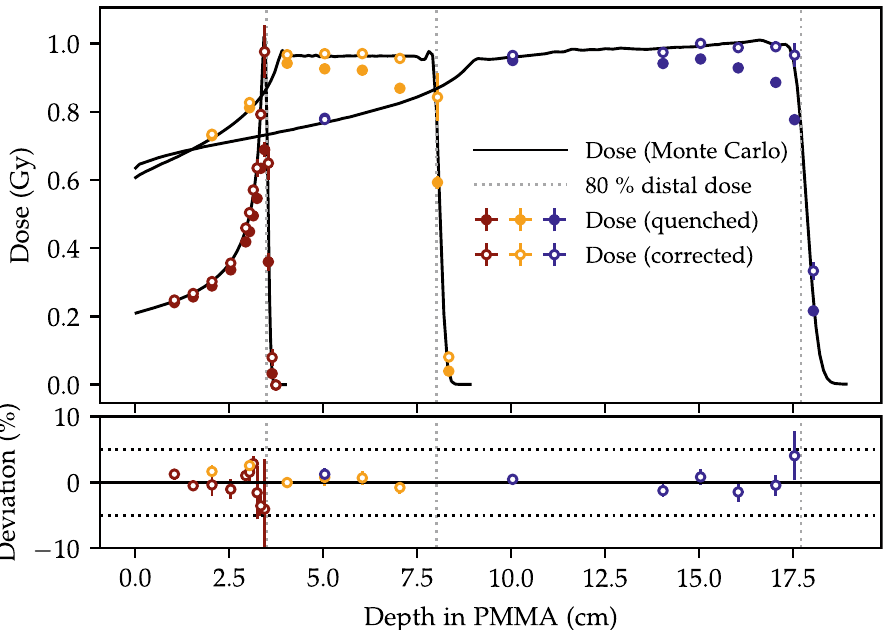
Figure 7. The measured quenched dose (filled markers) and corrected (open markers) for the three fields using only the emission in the blue band. The deviation of the measured LET from the simulated LET in the lower figure includes only the corrected doses below the 80 % distal dose edge (vertical, dotted